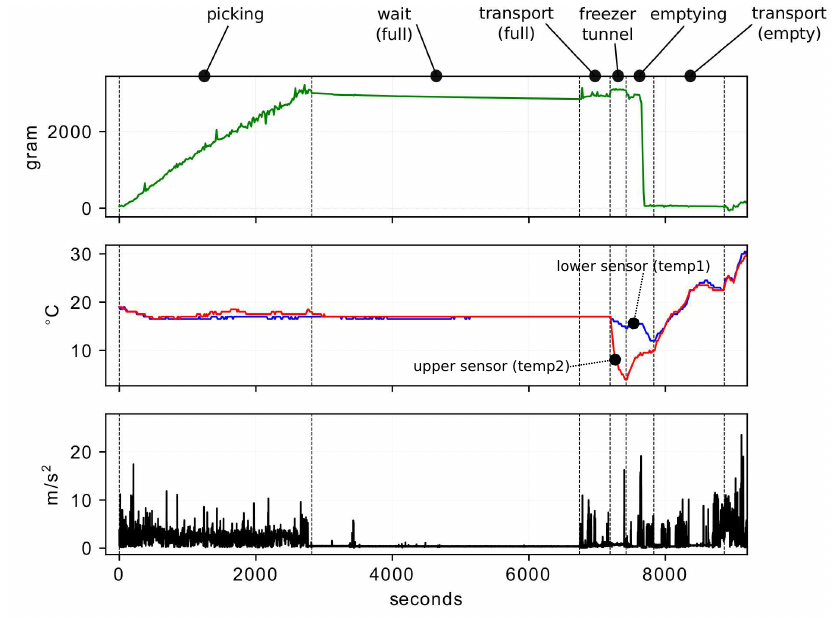
Figure 4. Summary of results of vibrations, weight, lower temperature (temp1) and upper temperature (temp2) sensors, for the first picking of the harvest basket corresponding to Node